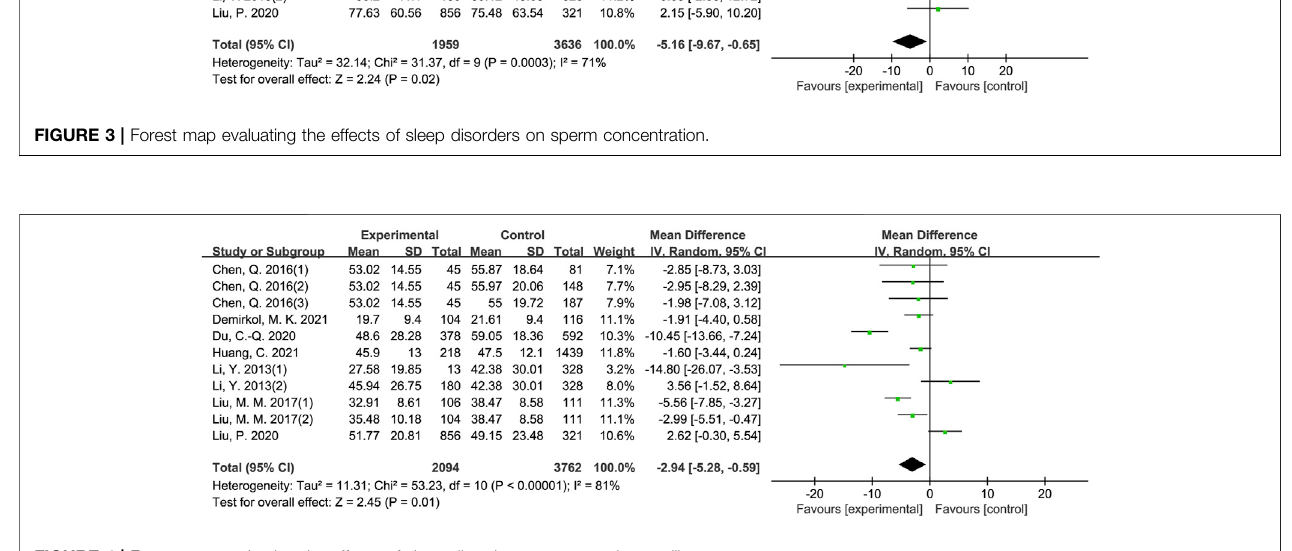
FIGURE 4 | Forest map evaluating the effects of sleep disorders on progressive motility.